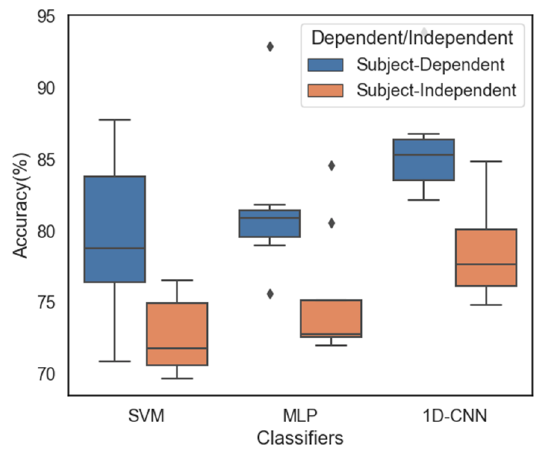
Figure 12. Comparison of the classification accuracies of the three classifiers for three emotions with both subject-dependent and subject-independent cases for eight subjects using SAE.